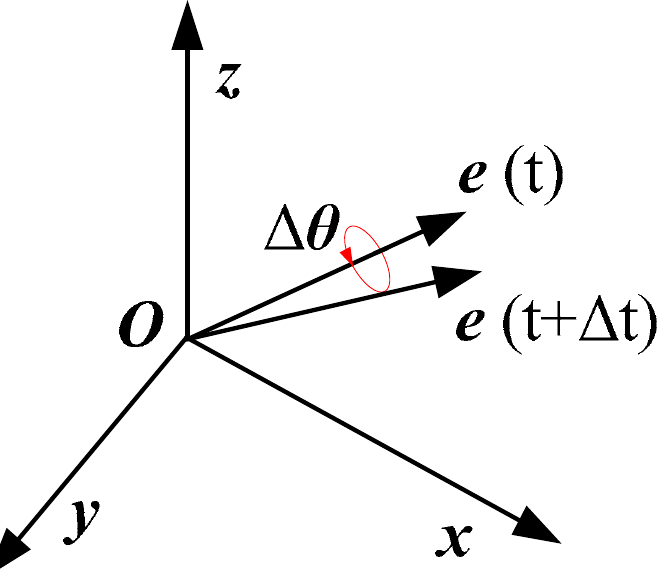
Figure 4. Vector rotation schematic.